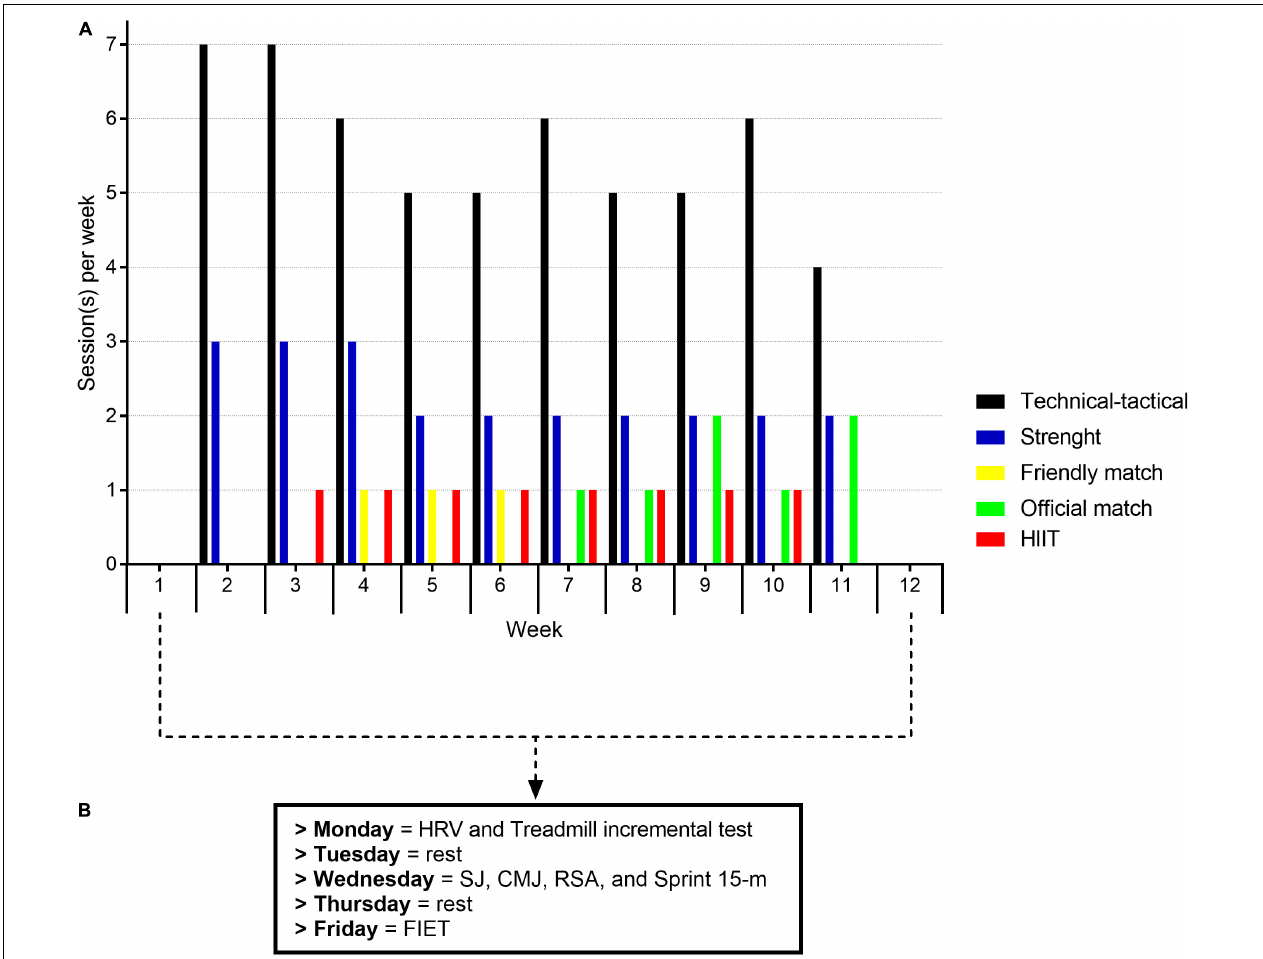
FIGURE 1 | Experimental design with the number of each training/match session type in each week (A) , and the testing sessions at pre and post 10 weeks of training (B) . HIIT, high intensity interval training; HRV, heart rate variability; SJ, squat jump; CMJ, counter movement jump; RSA, repeated sprint ability test; FIET, Futsal Intermittent Endurance